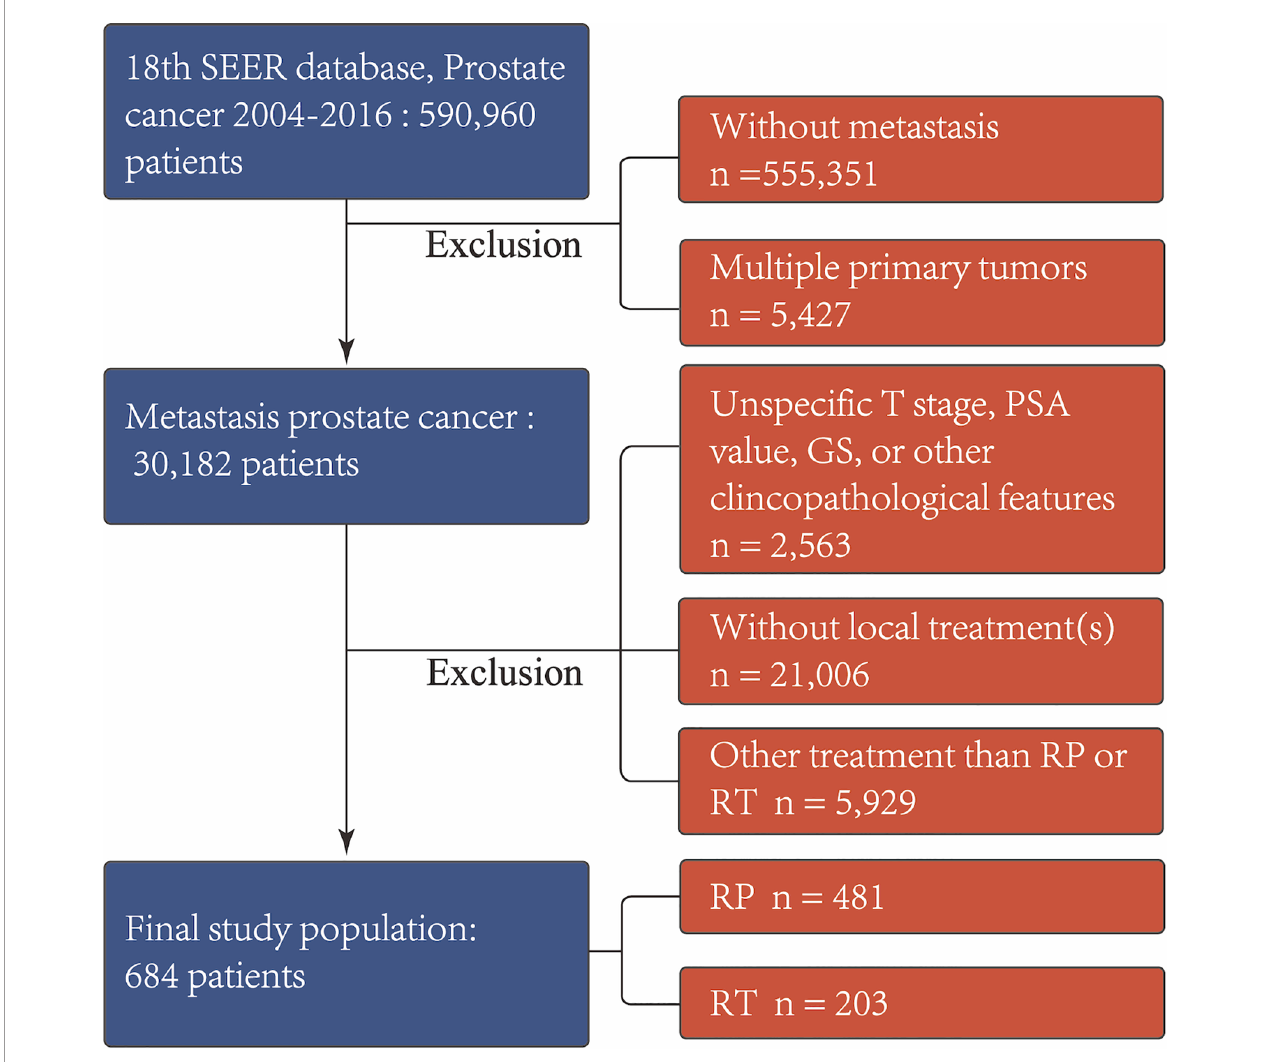
FIGURE 1 | Exclusion criteria used to derive the fi nal study cohort from the SEER database from 2004 to 2016. RP , radical prostatectomy with or without external beam radiation therapy; RT , brachytherapy with or without external beam radiation therapy; PSA , prostate-speci fi c antigen; GS , Gleason